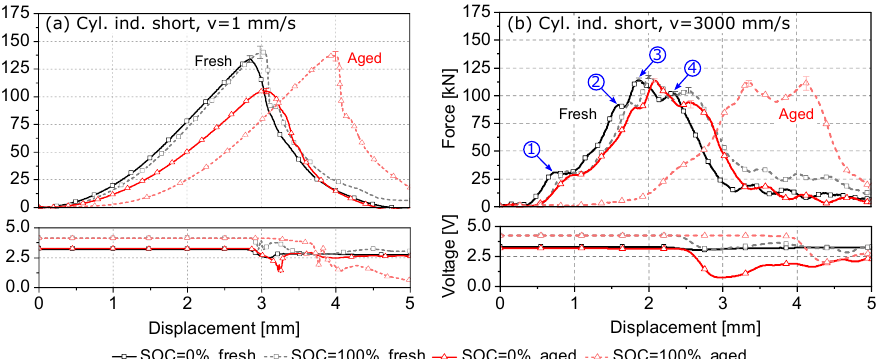
Figure 7. Comparison of the cylindrical indentation test results along the short cell side for fresh and electrical aged lithium-ion cells: ( a ) Quasistatic results at v = 1mm/s by Sprenger et al. [27] and ( b ) dynamic results at v =